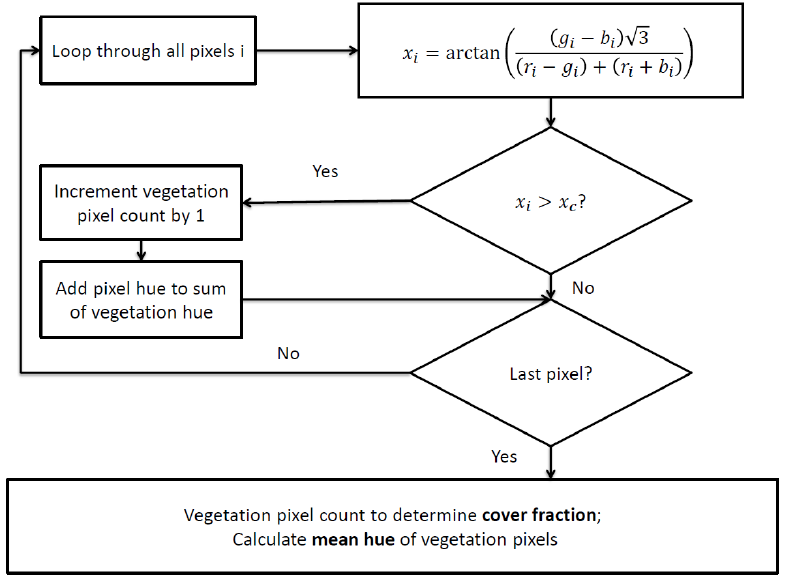
Figure 4. Flow chart of image processing algorithms for wireless computer vision